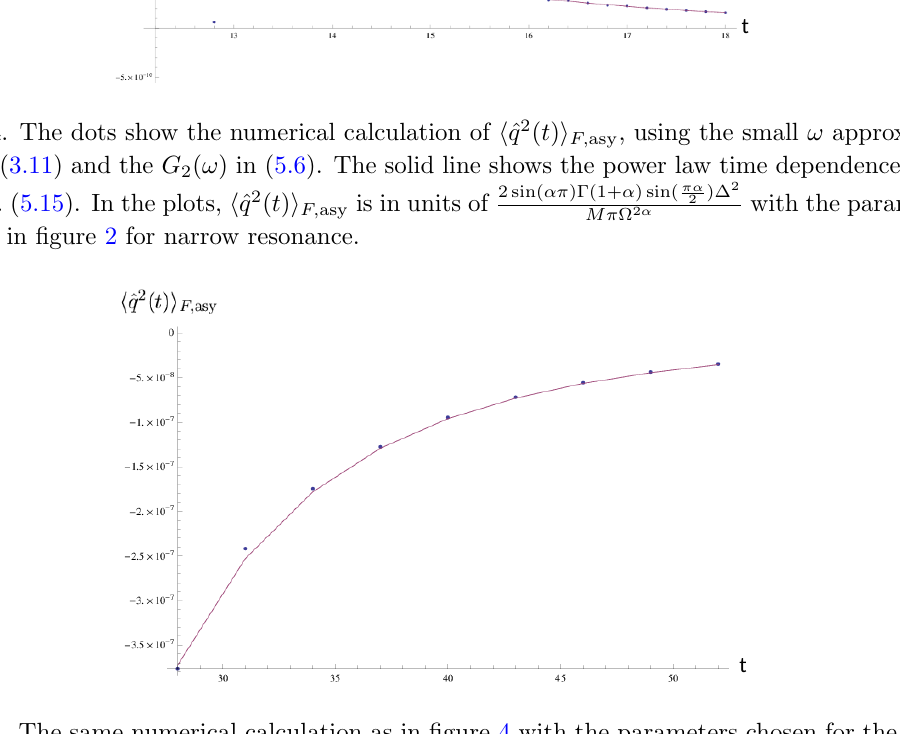
Figure 5 . The same numerical calculation as in (cid:12)gure 4 with the parameters chosen for the broad resonance as in (cid:12)gure